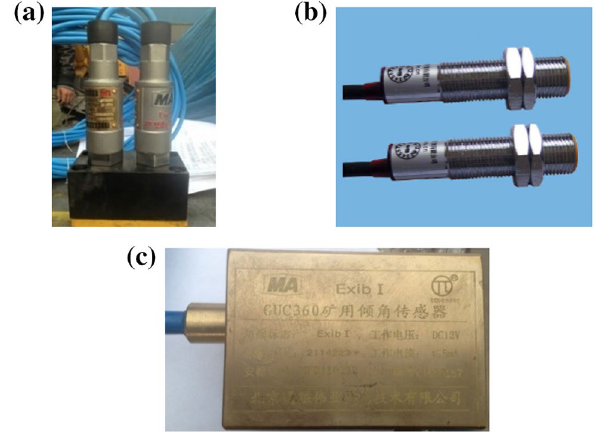
Fig. 16 Pictures of the experimental equipment [17, 18]. ( a ) Pres- sure transmitter; ( b ) Dual speed sensor; ( c ) Angle